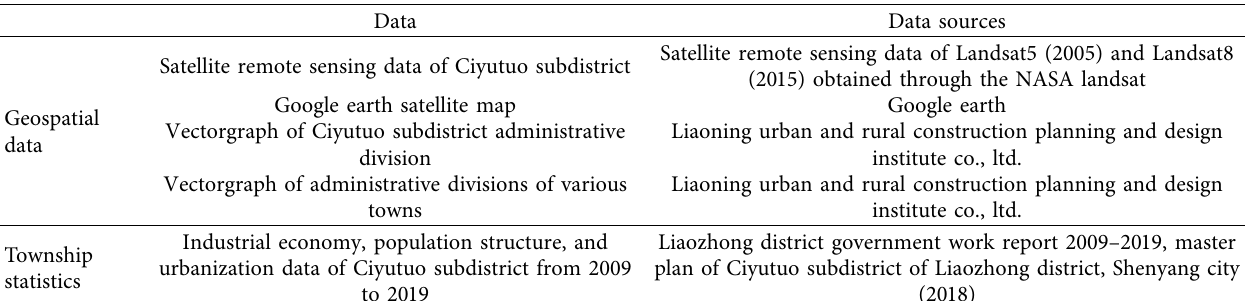
Figure 1: Location of the study area. Table 1: Summary of data and sources used in this